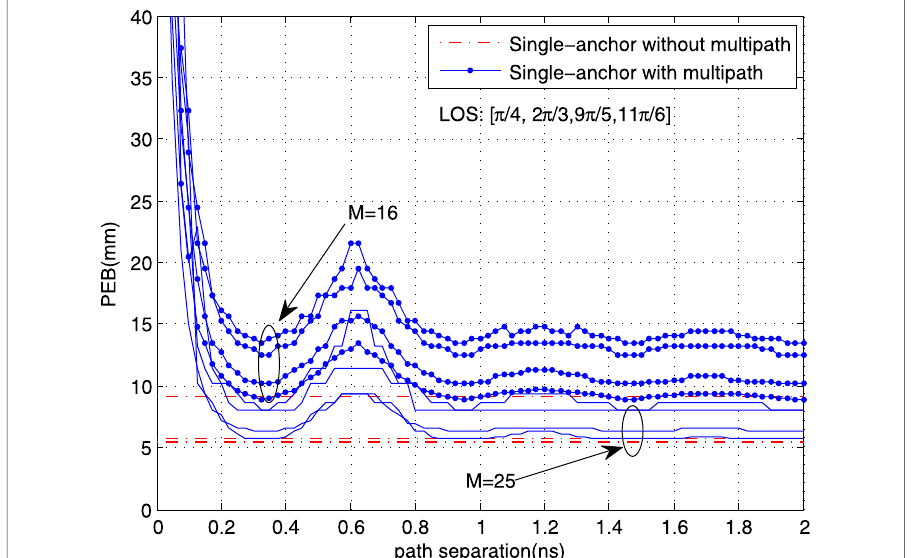
Fig. 9 PEB of single anchor localization without cooperation, as a function of path separation, where different antenna elements are